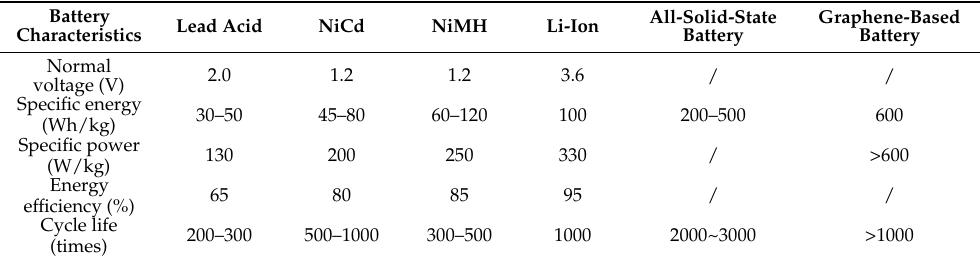
Table 1. Comparison of the performances of various power batteries